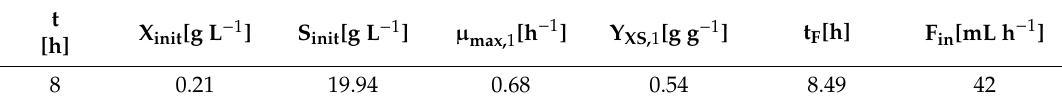
Table A9. Estimated initial concentrations for biomass X init and glucose S init and the estimated model parameters for maximum specific growth rate biomass µ max and yield coe ffi cient biomass / substrate Y XS at process timepoint t. Calculated glucose drop time at t F and calculated optimized feed rate F in for timepoint t F .